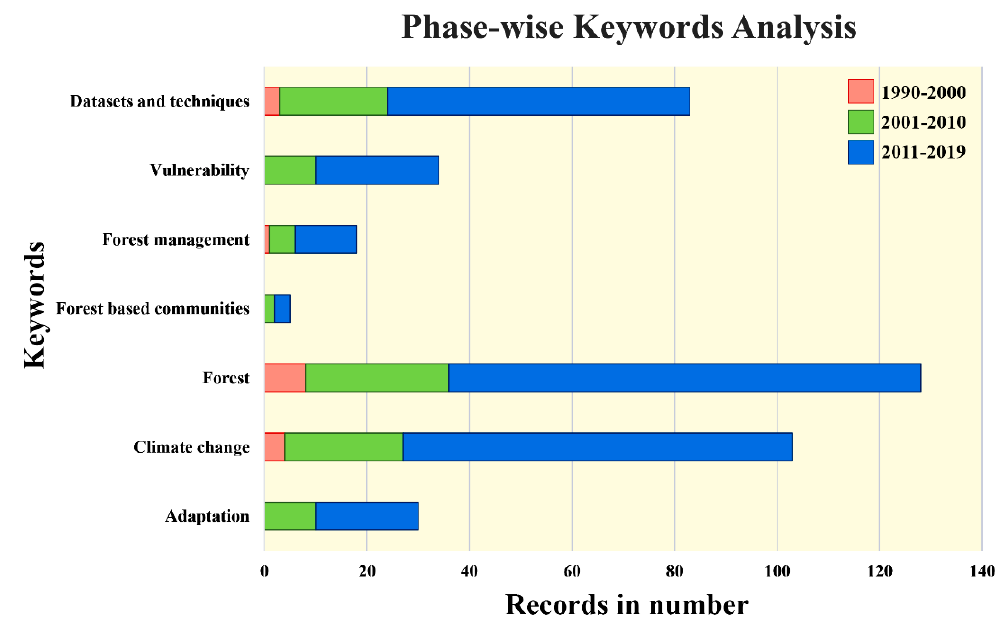
Figure 5. Keywords analysis during a different phase of systematic review.